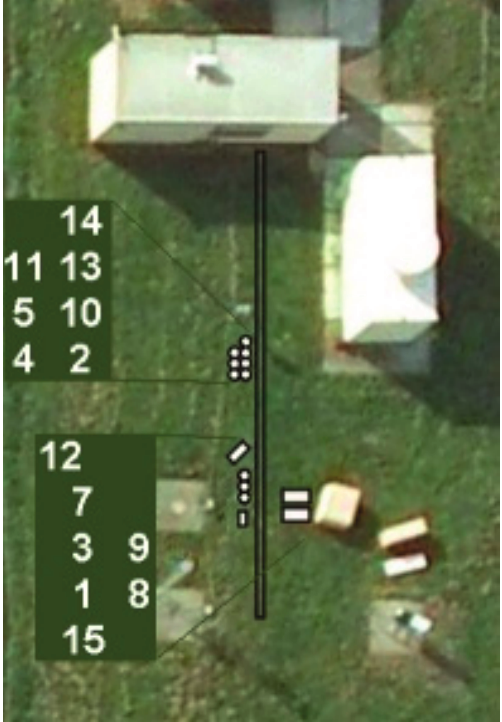
Figure 2. The average luminance per night for each SQM divided by the average derived from the reference is plotted as a function of the denominator.